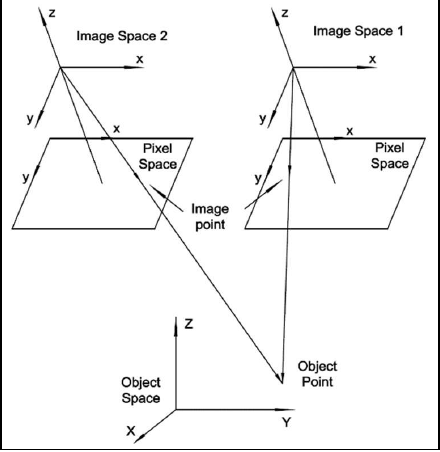
Figure 3. Collinearity condition illustration for an image